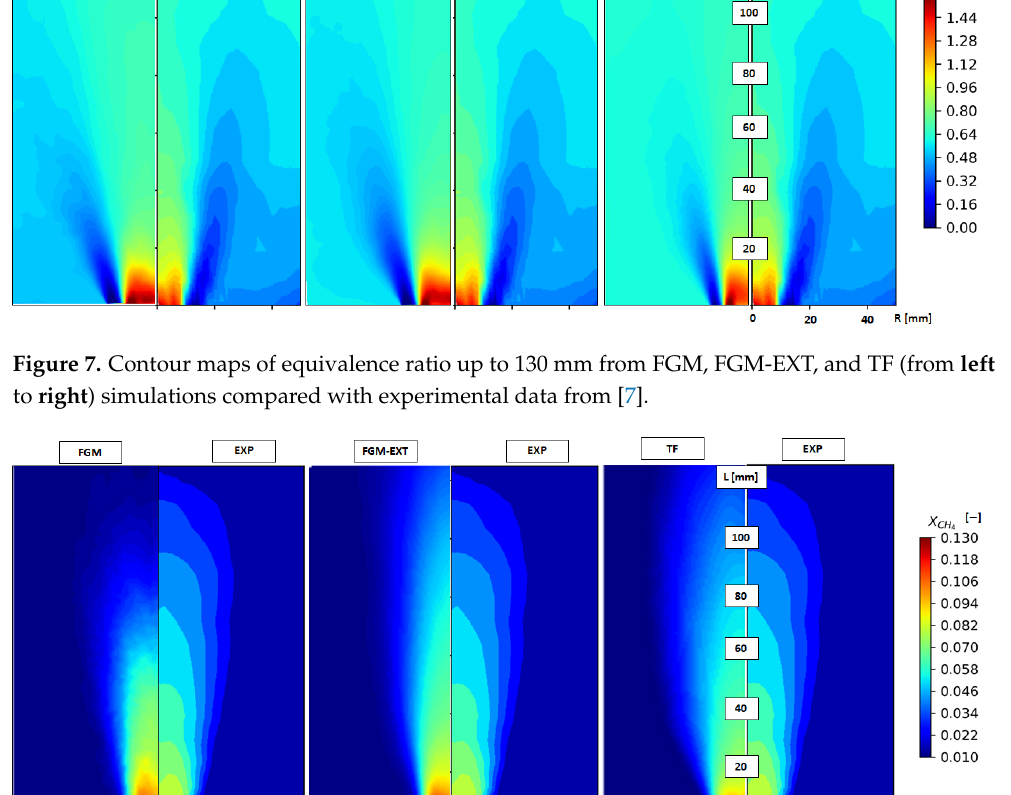
Figure 8. Contour maps of the CH 4 mole fraction ( X CH with experimental maps adapted from [5].